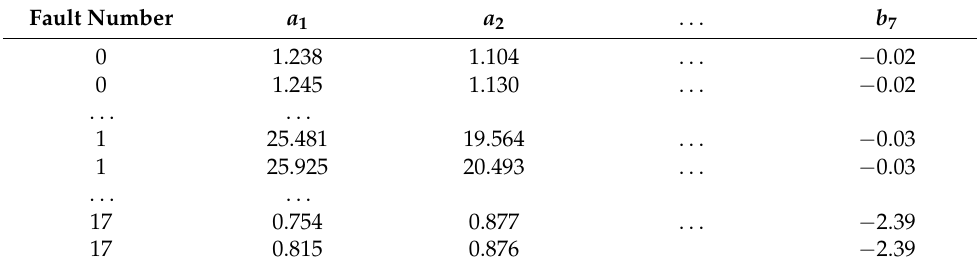
Table 4. HV cable grounding system fault database.